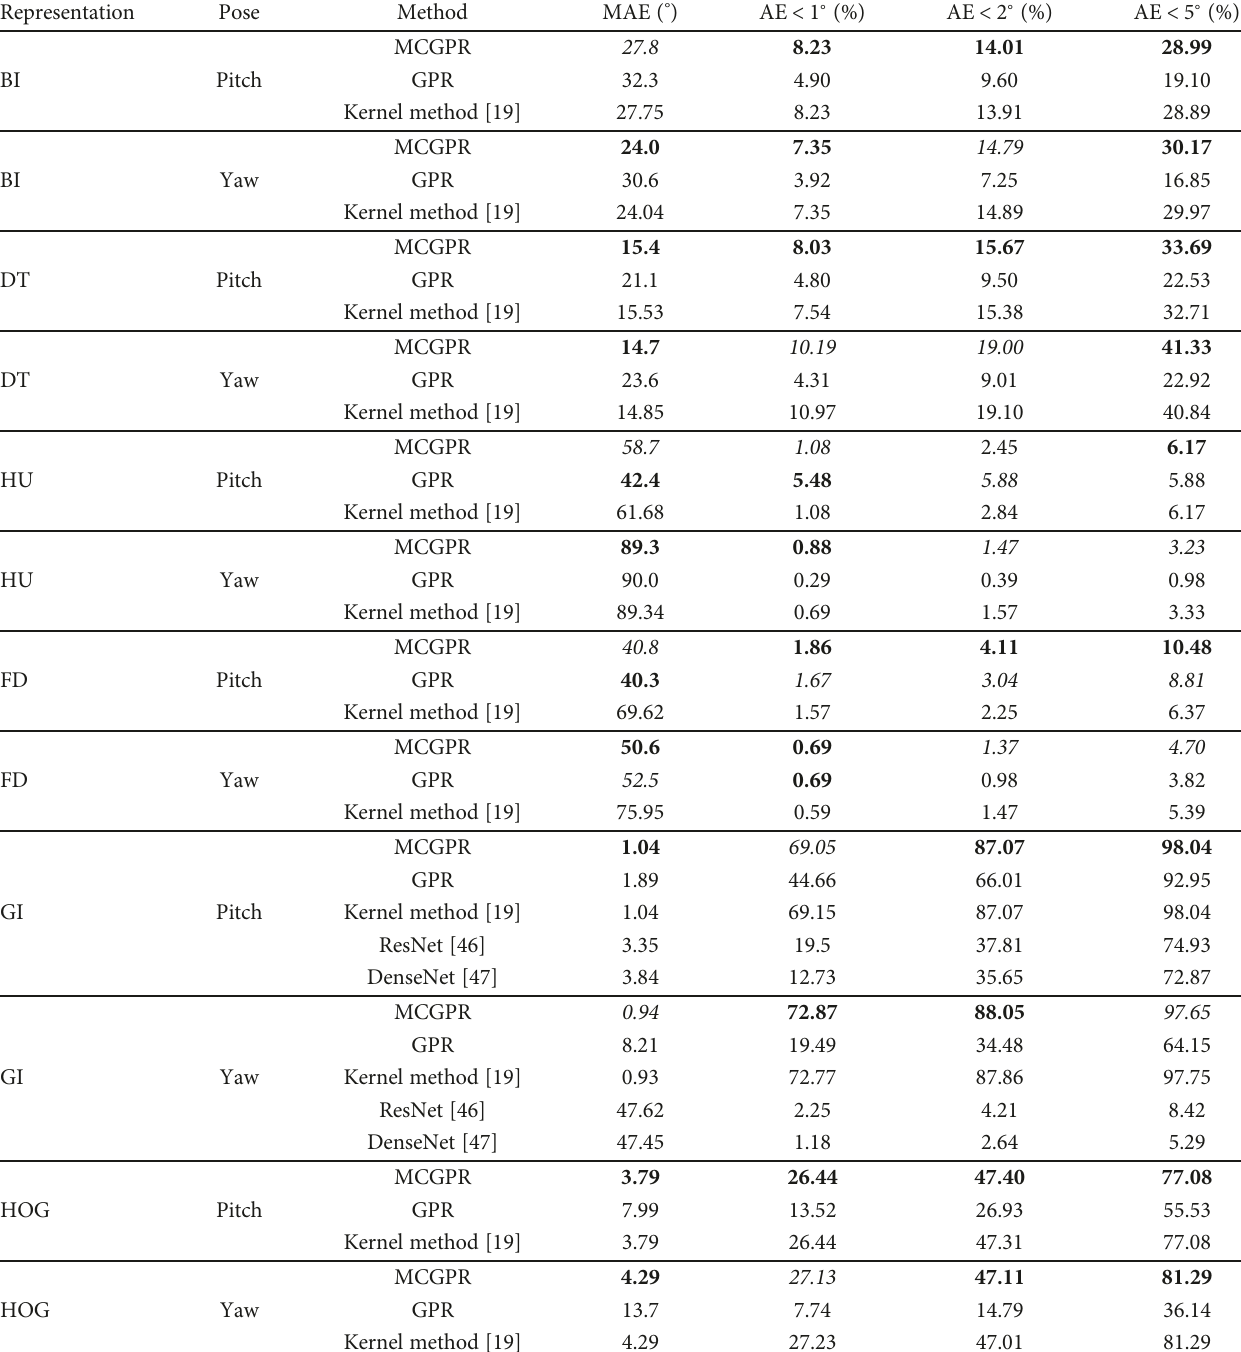
Table 6: Pose estimation results on the 2D subset of BUAA-SID 1.5. Results are in bold if the proposed method performs the best and in italic if the second